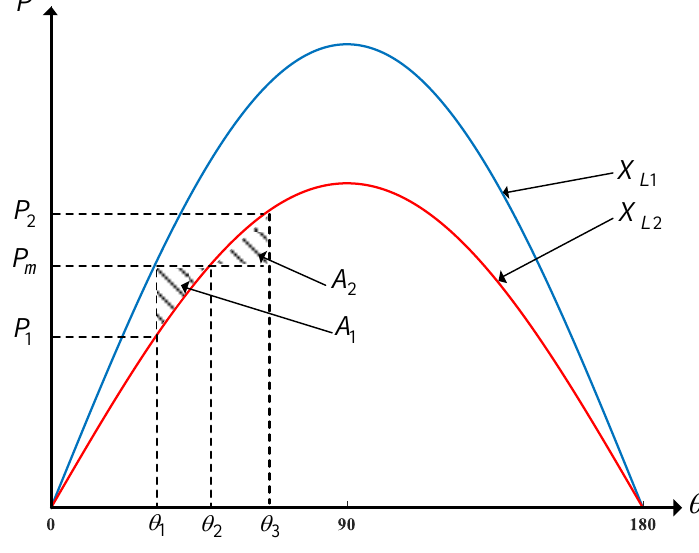
Figure 2. Active power transferred from the generator to the grid versus